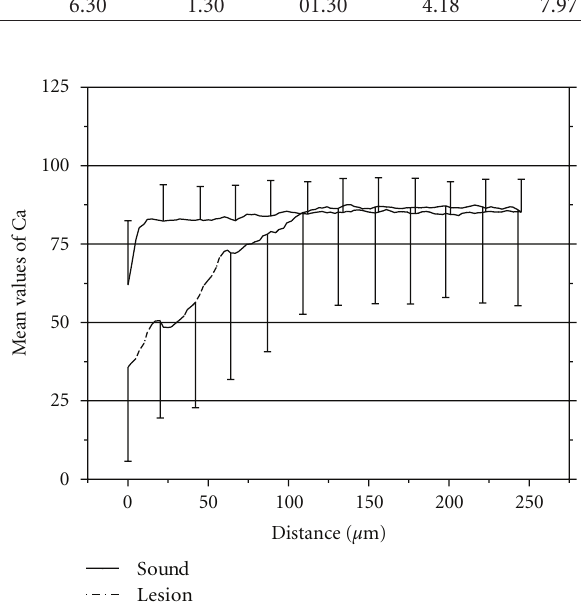
Figure 5: Graph of the mean values and standard deviations of wt% calcium in XRMA (linescans) in sound enamel and in lesion from the enamel surface till approximately 250 μ m in the